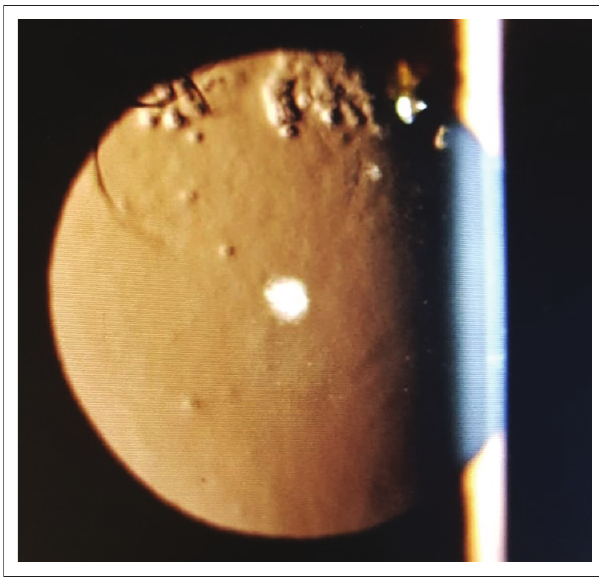
FIGURE 1: A retroillumination image of the left eye showing peripheral crystalline lens opacities concentrated superiorly, with diffuse opacities that respect the visual axis.